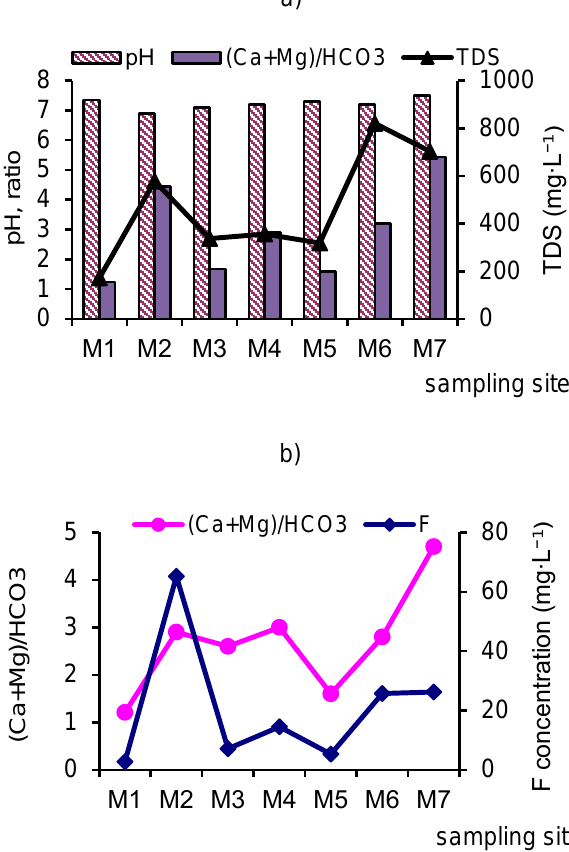
Figure 4. Variation of the equivalent ratio (Ca 2 + + Mg 2 + ) / HCO 3 − with total dissolved solids (TDS), value pH ( a ) and with fluoride concentration ( b ).